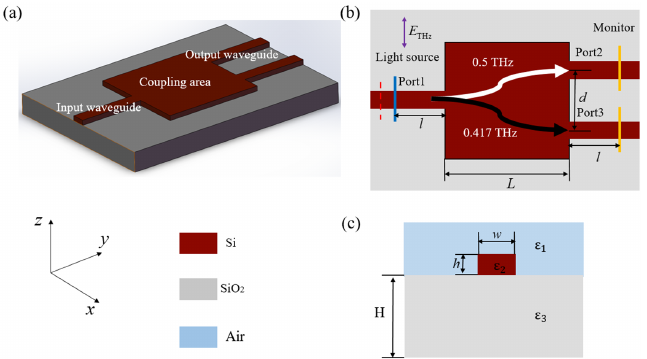
Figure 2. Three-dimensional schematic diagram ( a ), top view ( b ) and waveguide cross section ( c ) of the initial structure for the two-port THz demultiplexer. The blue and orange lines in ( b ) represent the positions of the light source and 2D monitors in the FDTD simulation, respectively. L = 3 mm, d = 1.5 mm, w = 400 μ m, h = 200 μ m, H = 500 μ m, ε 1 = 1, ε 2 = 11.7 and ε 3 = 3.8.